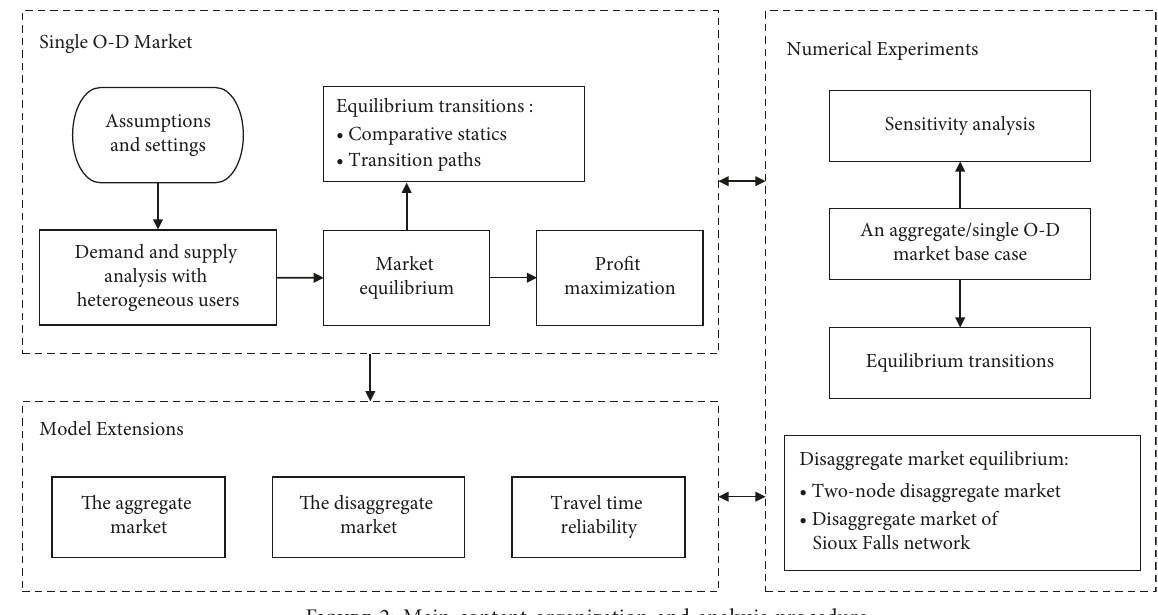
Figure 2: Main content organization and analysis procedure. Table 1: Notational glossary for the single O-D